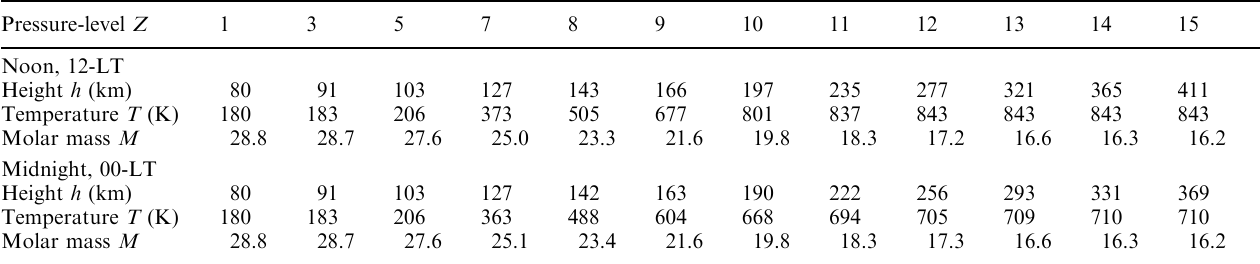
(cid:136) 100 10.7